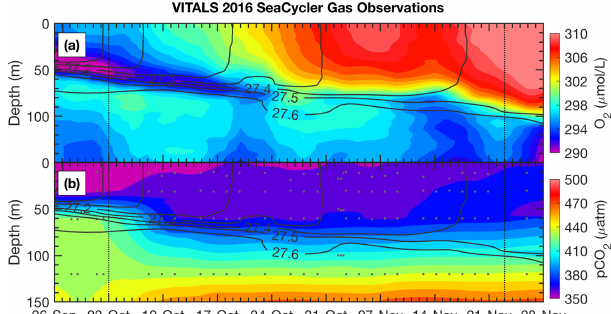
Figure 5. SeaCycler time evolution of (a) O 2 and (b) p CO 2 obser- vations for the joint glider–SeaCycler sampling period with isopy- cnal anomaly contours overlaid (0.1kgm − 3 spacing). Small grey dots are the depth and time of discrete CO 2 -Pro CV measurements by the SeaCycler. Vertical dotted lines indicate the start and end of the joint sampling